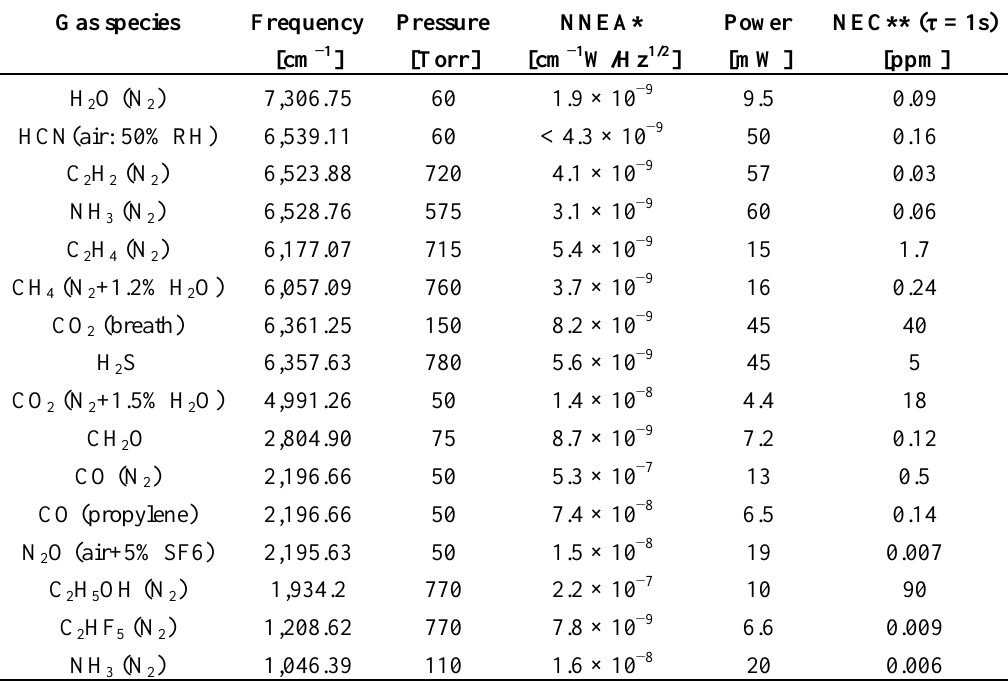
Table 3. QEPAS detection of trace